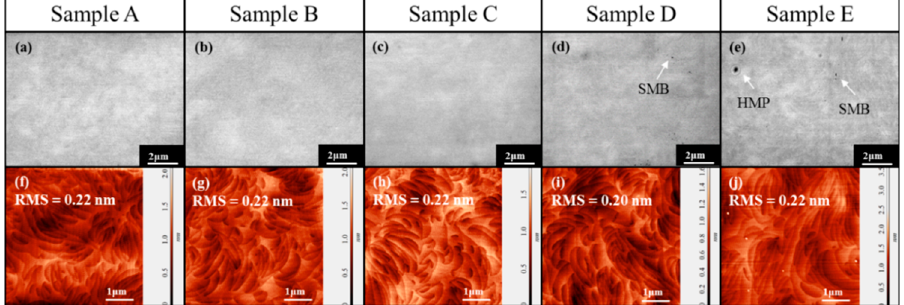
Figure 3. ( a – e ) SEM and ( f – j ) AFM images of the inserted SiN x nano-mask samples with various SiH 4 flow rates.